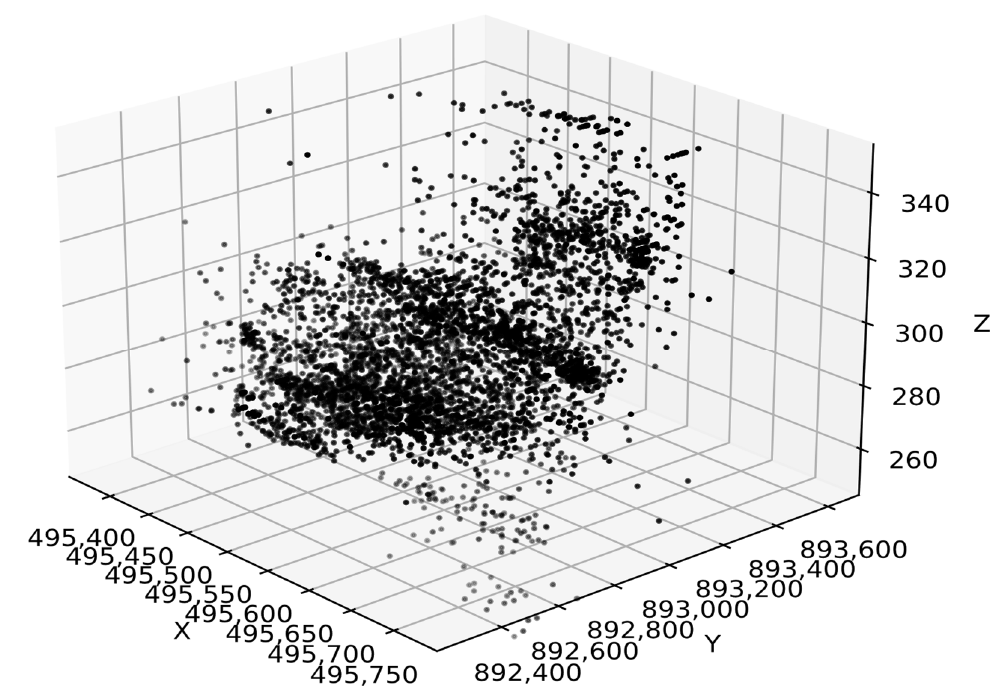
Figure 7. Distribution of microseisms in three-dimensional space.